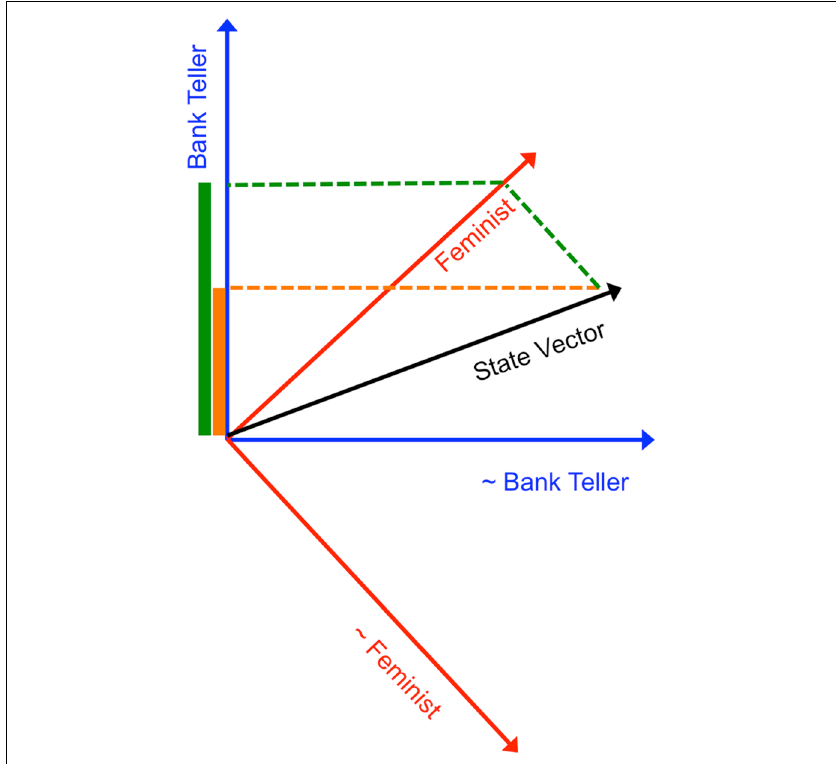
FIGURE 1 | The QP model for the conjunction fallacy. To calculate the probability that Linda is a bank teller, we project the state vector (shown in black) onto the bank teller subspace (shown in blue) and compute the squared length of this projection (shown in orange). To calculate the conjunction that Linda is both a feminist and a bank teller, we first project the state vector onto the feminist subspace (shown in red) and then project it onto the bank teller subspace and compute the squared length of this projection (shown in